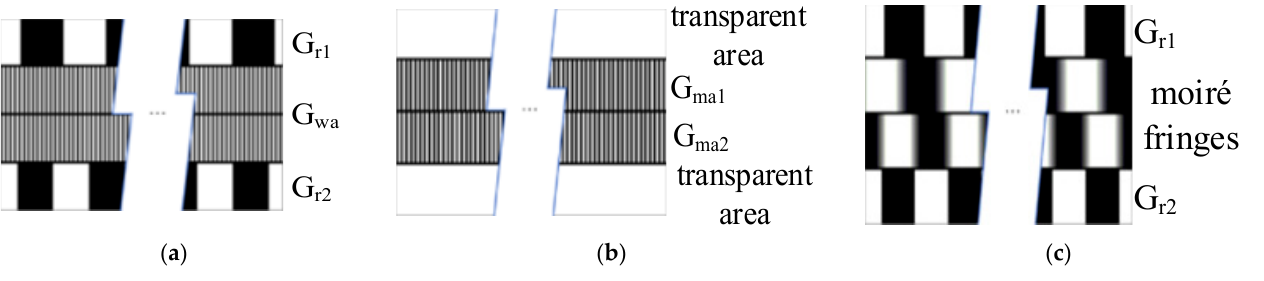
Figure 7. Alignment mark and Moiré fringe image. ( a ) Wafer alignment mark. ( b ) Mask alignment mark. ( c ) Moiré fringe image.